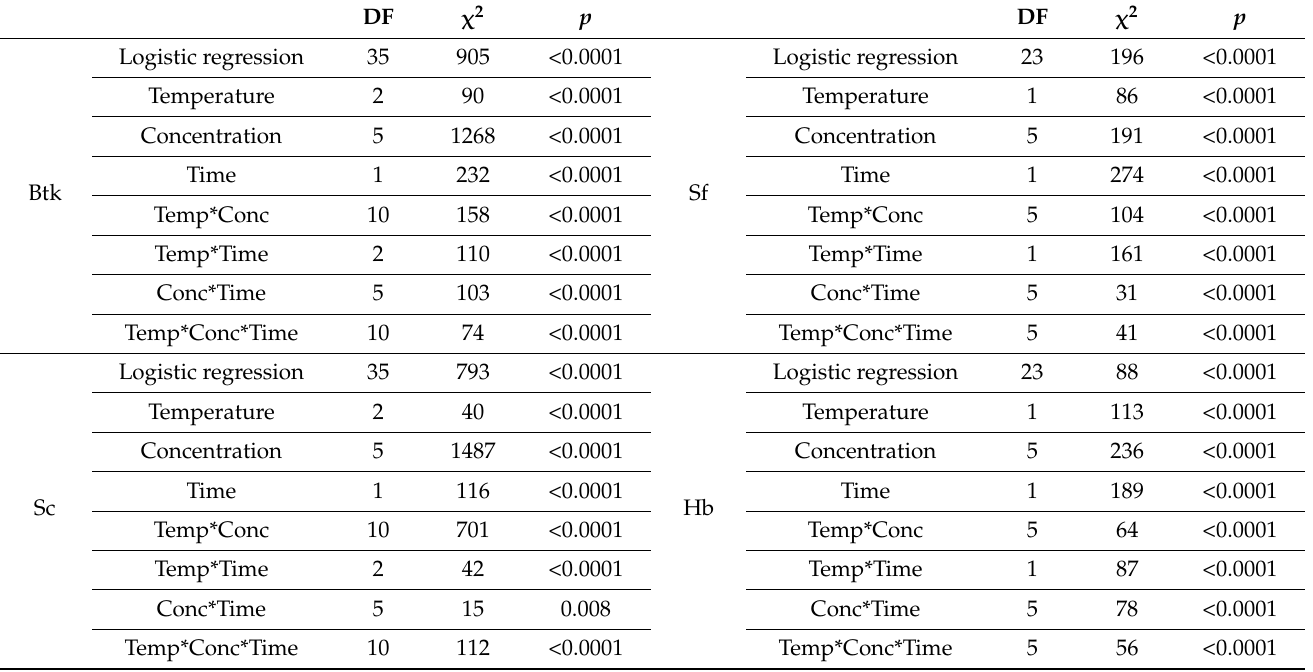
Table 1. Results of the logistic regression (logit model) carried out to compare SWD mortality at dif- ferent temperature conditions (Temp), concentrations (Conc), and times (Time) for each bioinsecticide (Btk: B. thuringiensis var. kurstaki , Sc: S. carpocapsae , Sf: S. feltiae , Hb: H. bacteriophora ). Statistics about the interactions between each couple of explicative variables, as well as between all three variables are also reported and indicated using *. Pairwise comparisons are reported in the Supplementary Material (Supplementary Materials Tables S1–S3). DF = degrees of